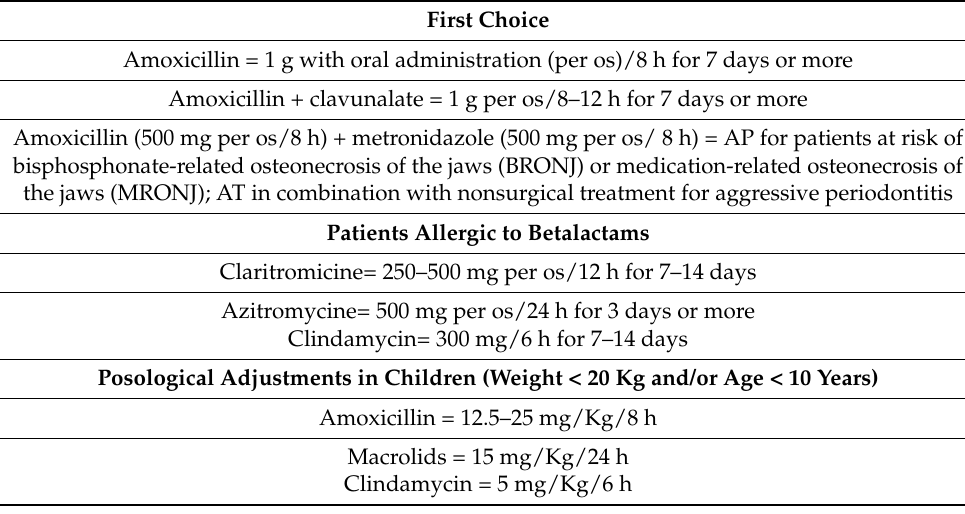
Table 1. Prolonged antibiotic schemes [11,12,14,15,17–21].